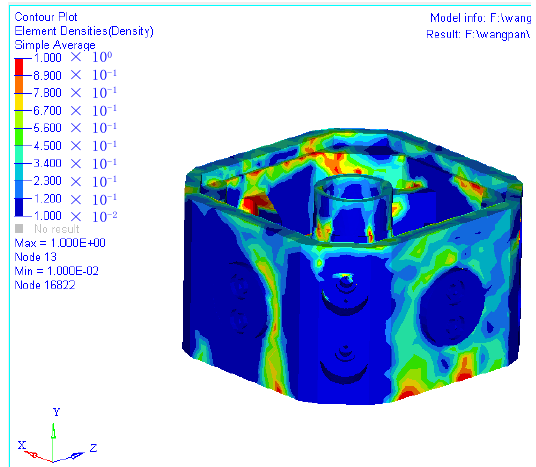
Figure 13. Density optimization analysis result of the assembly block.